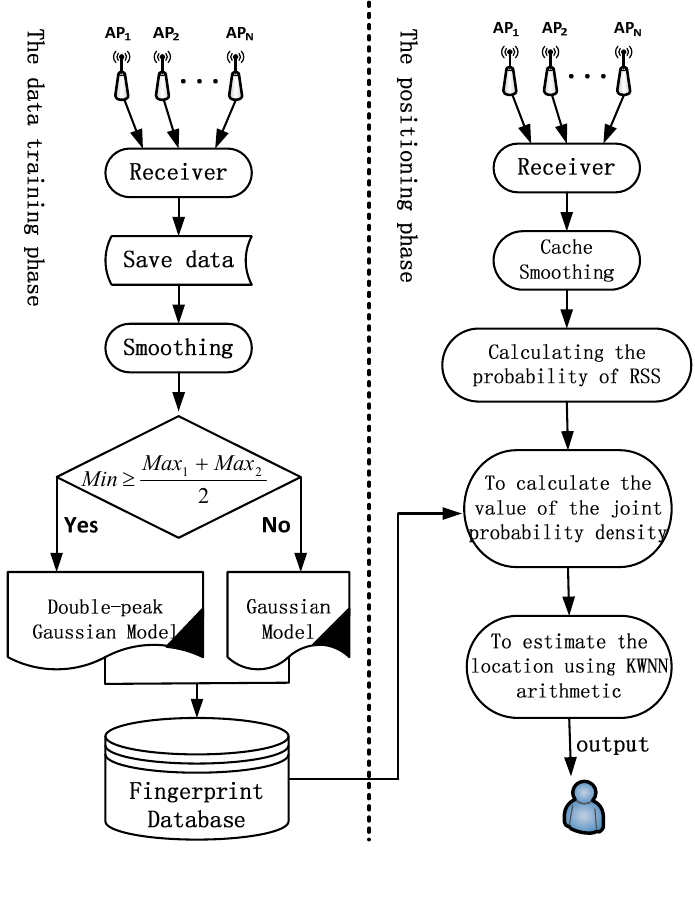
Figure 4. The procedure of positioning using proposed